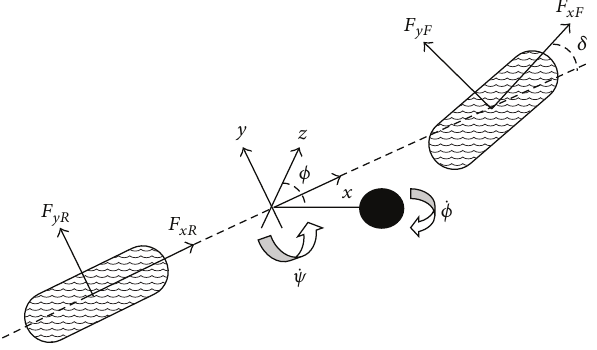
Figure 3: Single track model showing the combined front and rear tire forces, the steering angle, the yaw rate, and the vehicle sideslip angle